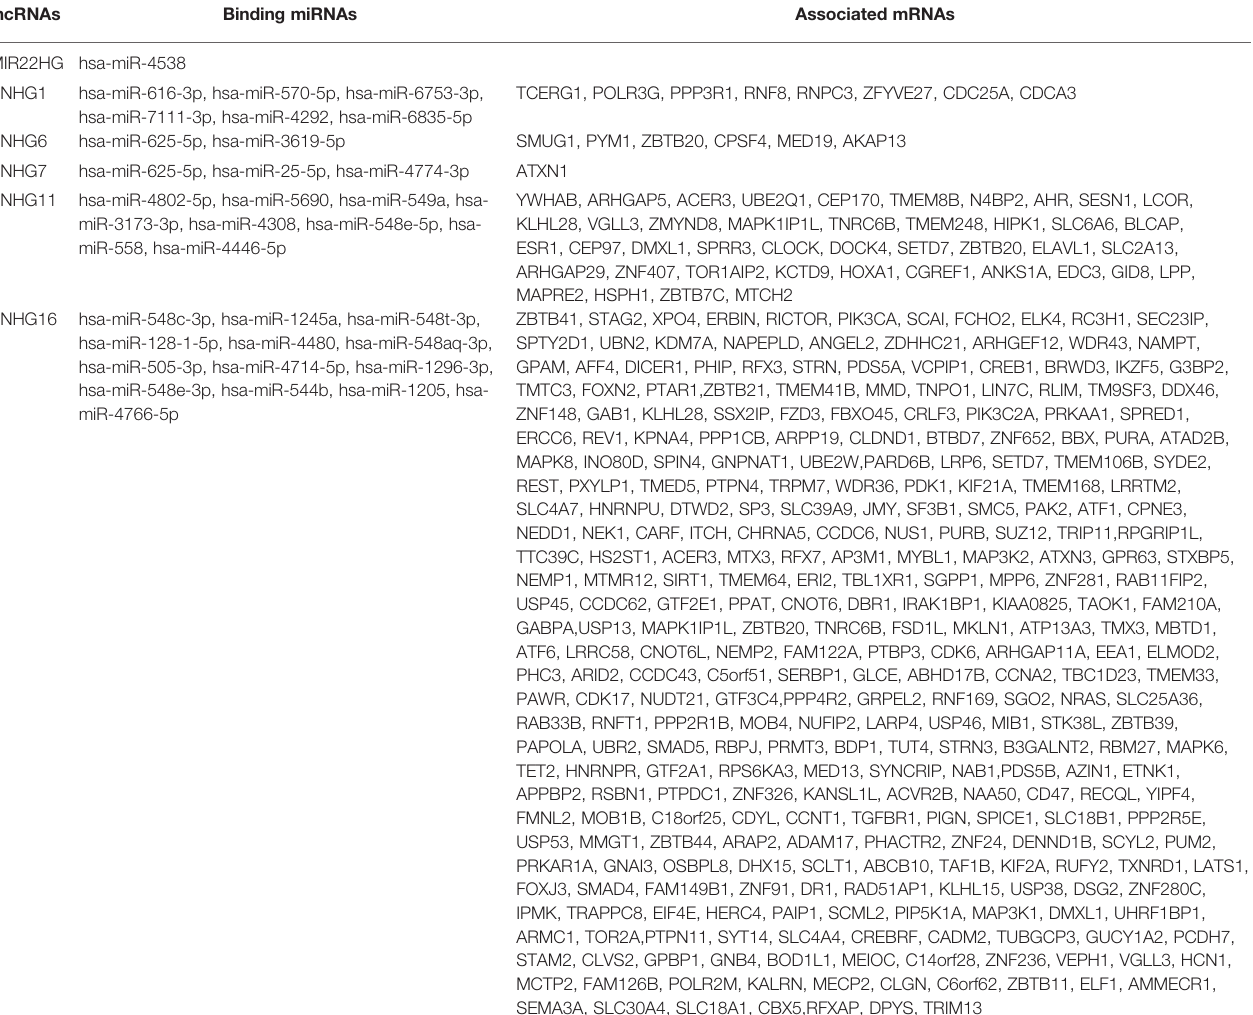
TABLE 2 | lncRNAs, miRNAs and mRNAs in the ceRNA Network. lncRNAs Binding miRNAs Associated